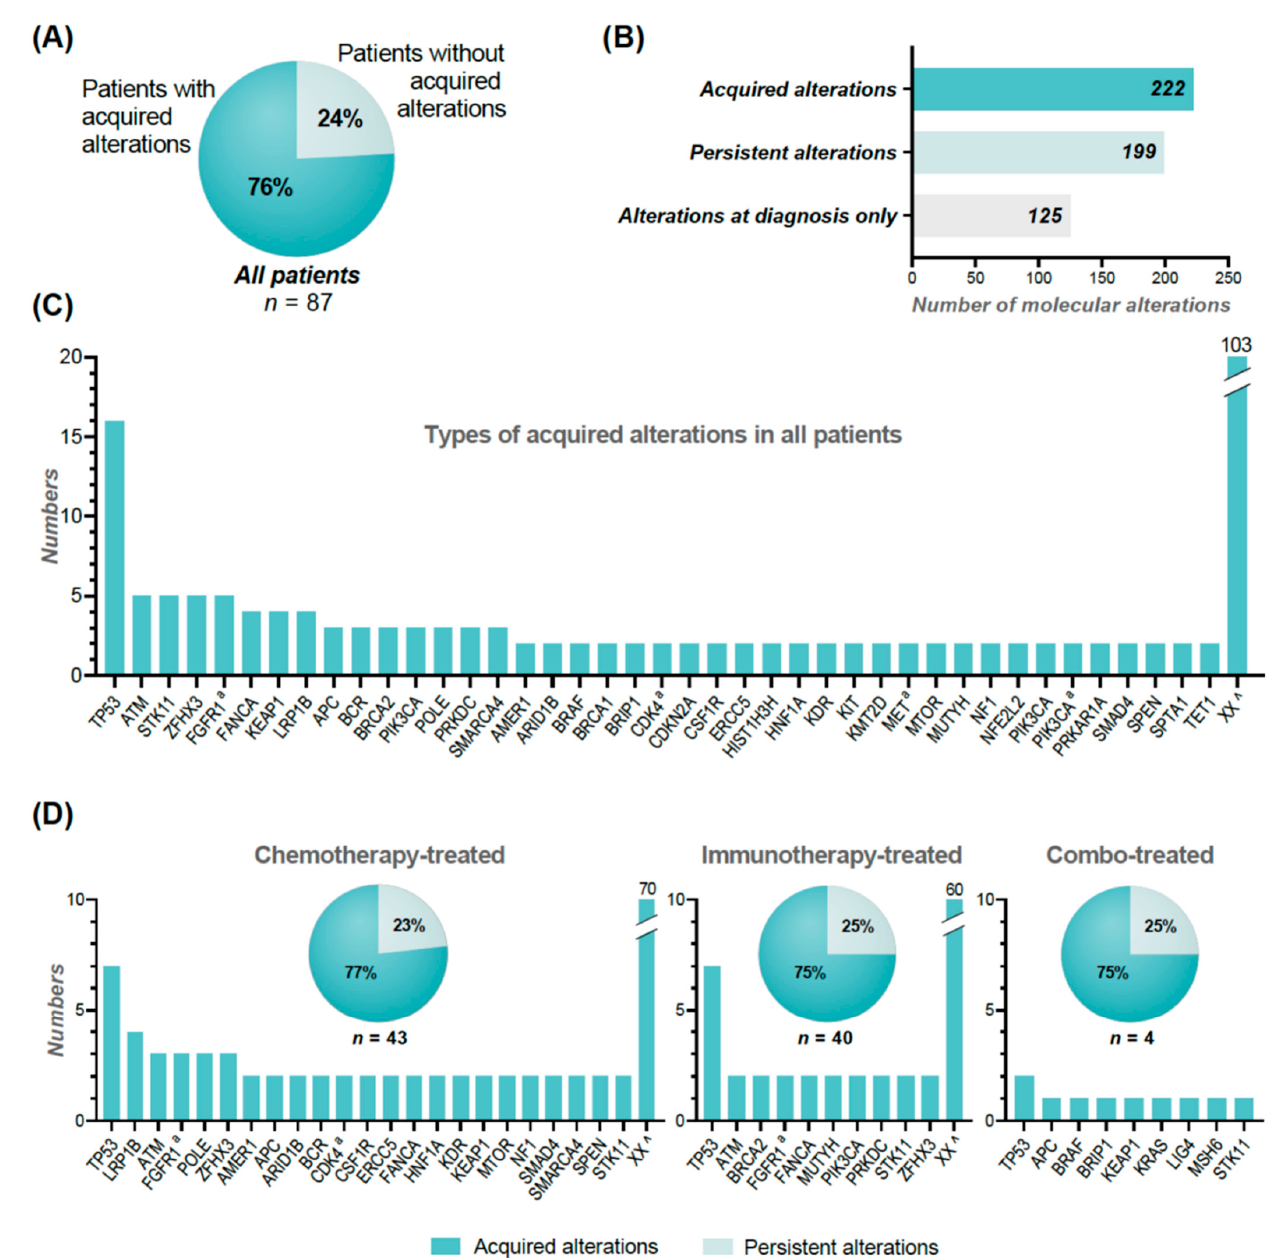
Figure 4. ( A ) illustrates the percentage of patients with or without acquired alterations. ( B ) shows the number of acquired, persistent, and diagnostic (only) alterations. ( C ) illustrates the types and frequencies of the acquired alterations in all patients. ( D ) illustrates the types and frequencies of acquired alterations in chemotherapy-treated, immunotherapy-treated, and combo-treated patients. a denotes amplifications. XX ^ represents different alterations occurring one